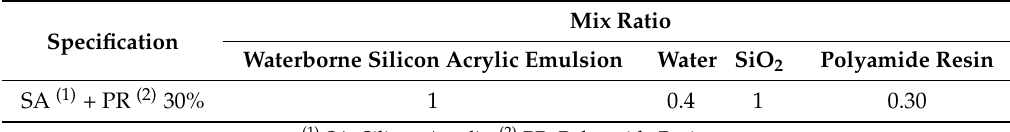
Table 1. Mix ratio of developed surface